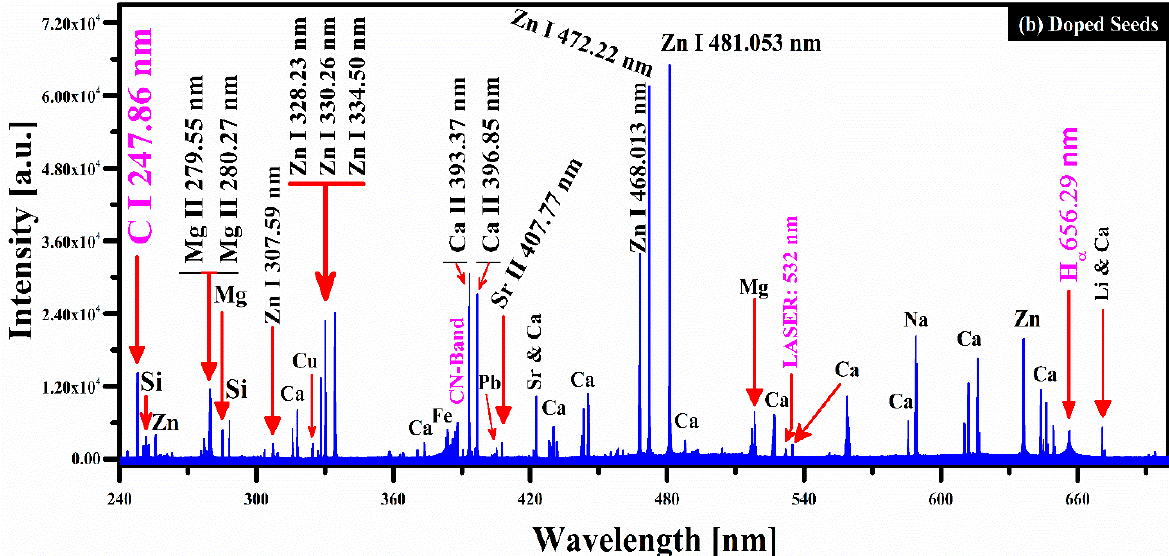
Figure 2. The emission spectrum of the doped P. harmala seed sample-( δ ) within the wavelength varies from 240 nm to 700 nm.